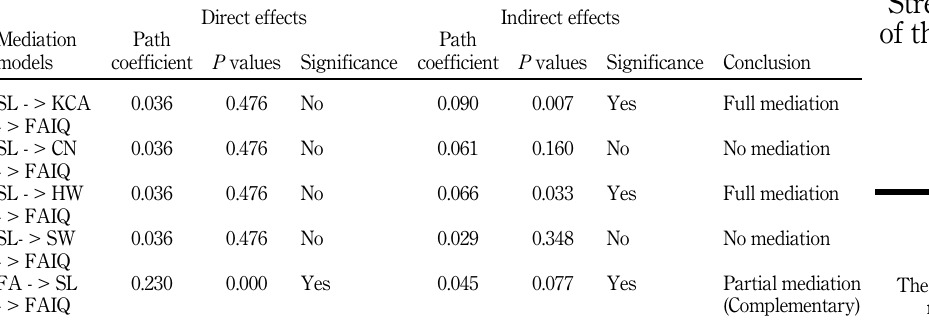
Table 4. The result of testing